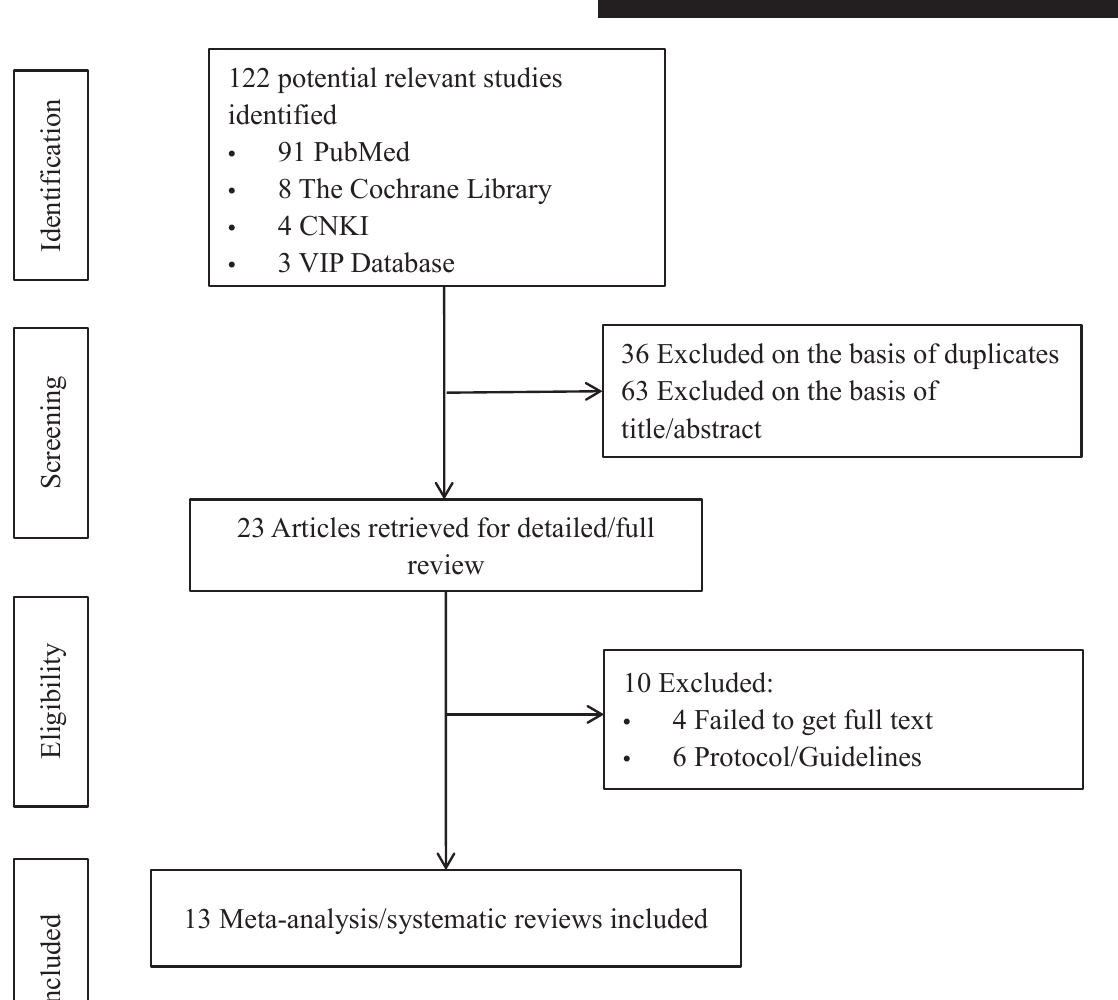
Figure 1. Literature screening